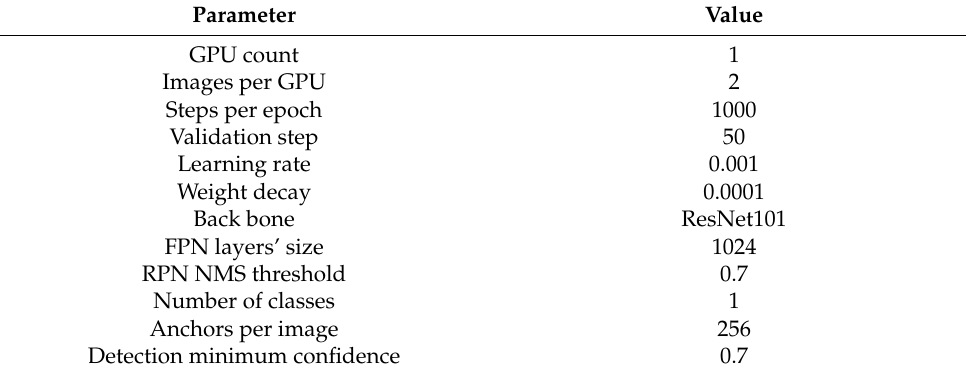
Table 1. Mask-RCNN network configuration.